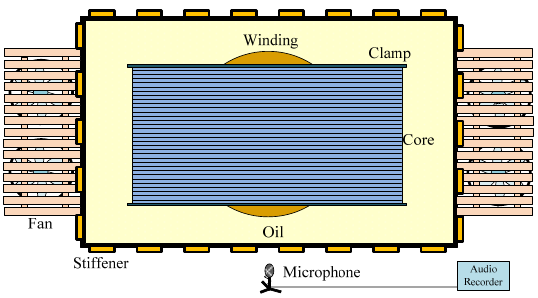
Figure 1. Schematic diagram of acoustic signal acquisition scheme for the transformer.